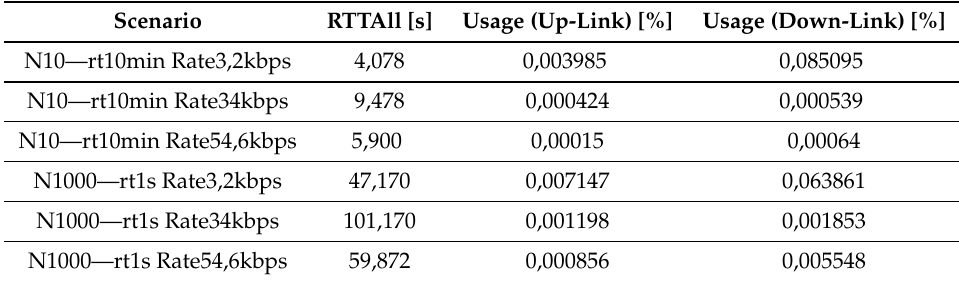
Table A1. Standard deviation of the results for the different scenarios analyzed with G3-PLC technology (Figure 9).